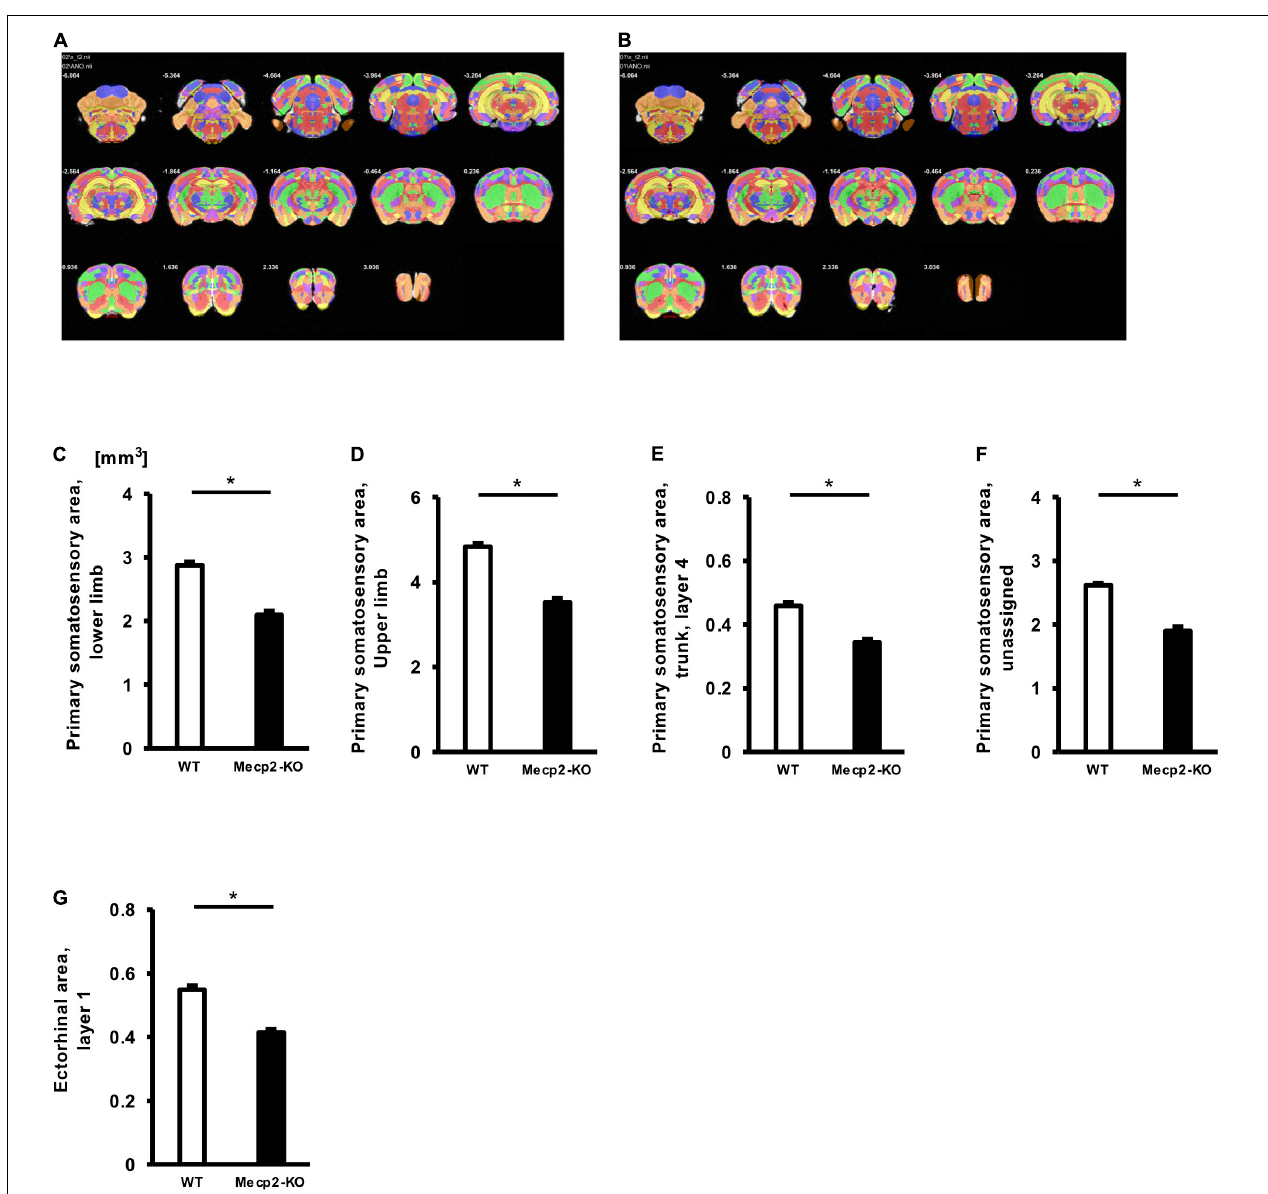
FIGURE 3 | Comparison between brain region volumes of WT and Mecp2 -KO mice obtained using detailed volume-based morphometry. Atlas registration and quantification of anatomical regions in WT mice (A) and Mecp2 -KO mice (B) were performed using detailed volume-based morphometry. A decrease in volume was detected in brain regions such as the primary somatosensory area, lower limb (E) , primary somatosensory area, mouth (C) , primary somatosensory area, upper limb (D) , primary somatosensory area, trunk, layer 4 (E) , primary somatosensory area, unassigned (F) , ectorhinal area, layer 1 (G) in Mecp2 -KO mice. Statistical test: Welch’s t -test. n = 4 mice per group. *Significant